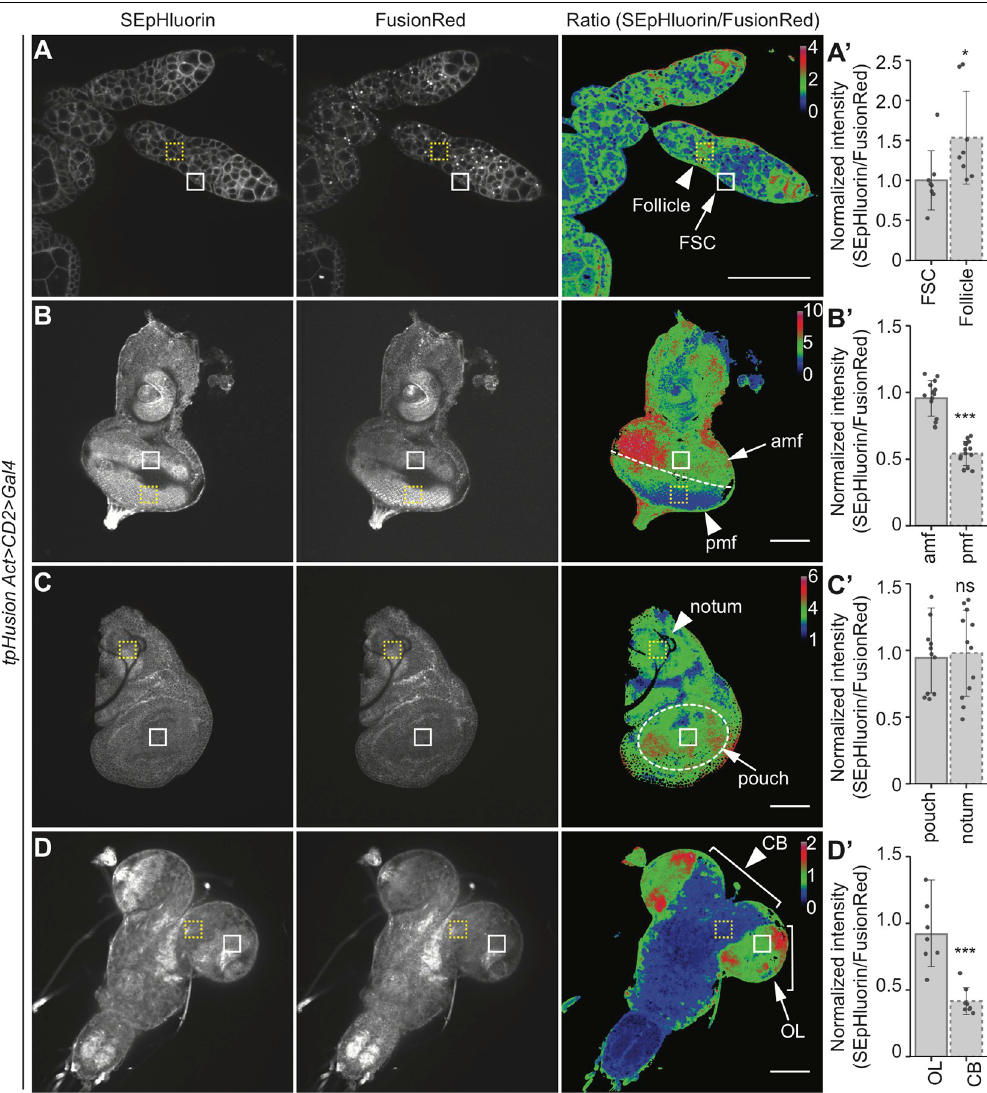
Fig 2. Comparison of pHi in different cell types of living tissues. (A-D) SEpHluorin, FusionRed, and ratiometric images of live (A) ovarioles, (B) eye discs, (C) wing discs, and (D) brains. (A’-D’) Quantification of the ratio of fluorescence intensities in (A’) FSC (arrow, white solid square) and follicle (arrowhead, yellow dashed square) cells, (B’) cells anterior (amf, arrow, white solid square) and posterior (pmf, arrowhead, yellow dashed square) to the morphogenetic furrow (dashed line), (C’) pouch (arrow, white solid square) and notum (arrowhead, yellow dashed square) cells, and (D’) cells in optic lobe (OL, arrow, white solid square) and central brain (CB, arrowhead, yellow dashed square). n > 7 larvae. Data are represented as mean ± standard deviation. � p < 0.05, ��� p < 0.001 and ns = not significant. Scale bar for A = 50 μ m, scale bar for B-D = 100 μ m. Calibration bar represents the ratio values of SEpHluorin to FusionRed intensities used to generate ratiometric